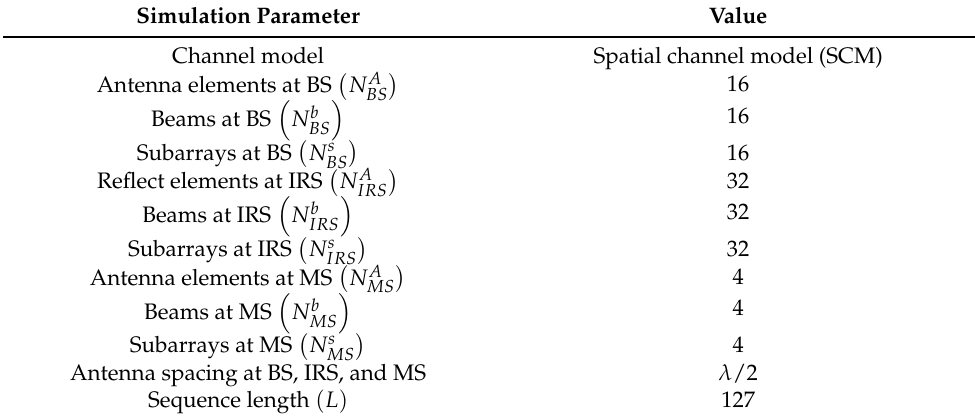
Table 2. Simulation